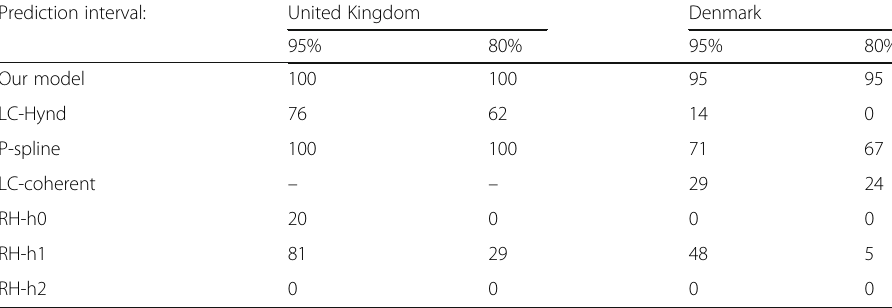
Table 2 Empirical frequencies to assess calibration of prediction intervals in the validating mortality forecasts for British and Danish men Prediction